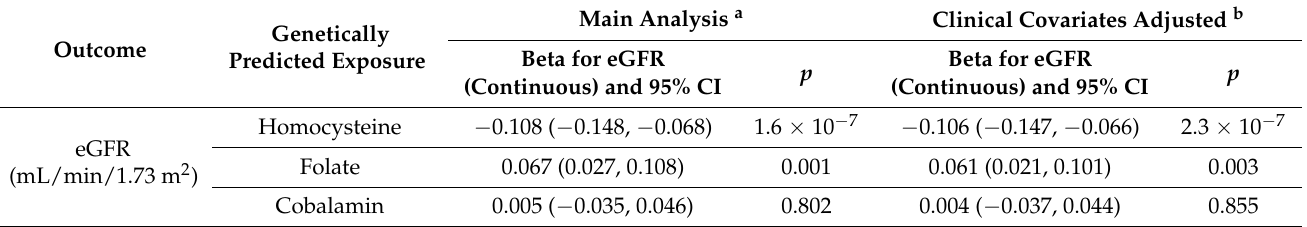
Table 3. Allele-score-based Mendelian randomization results with the U.K. Biobank data. Genetically Outcome Predicted